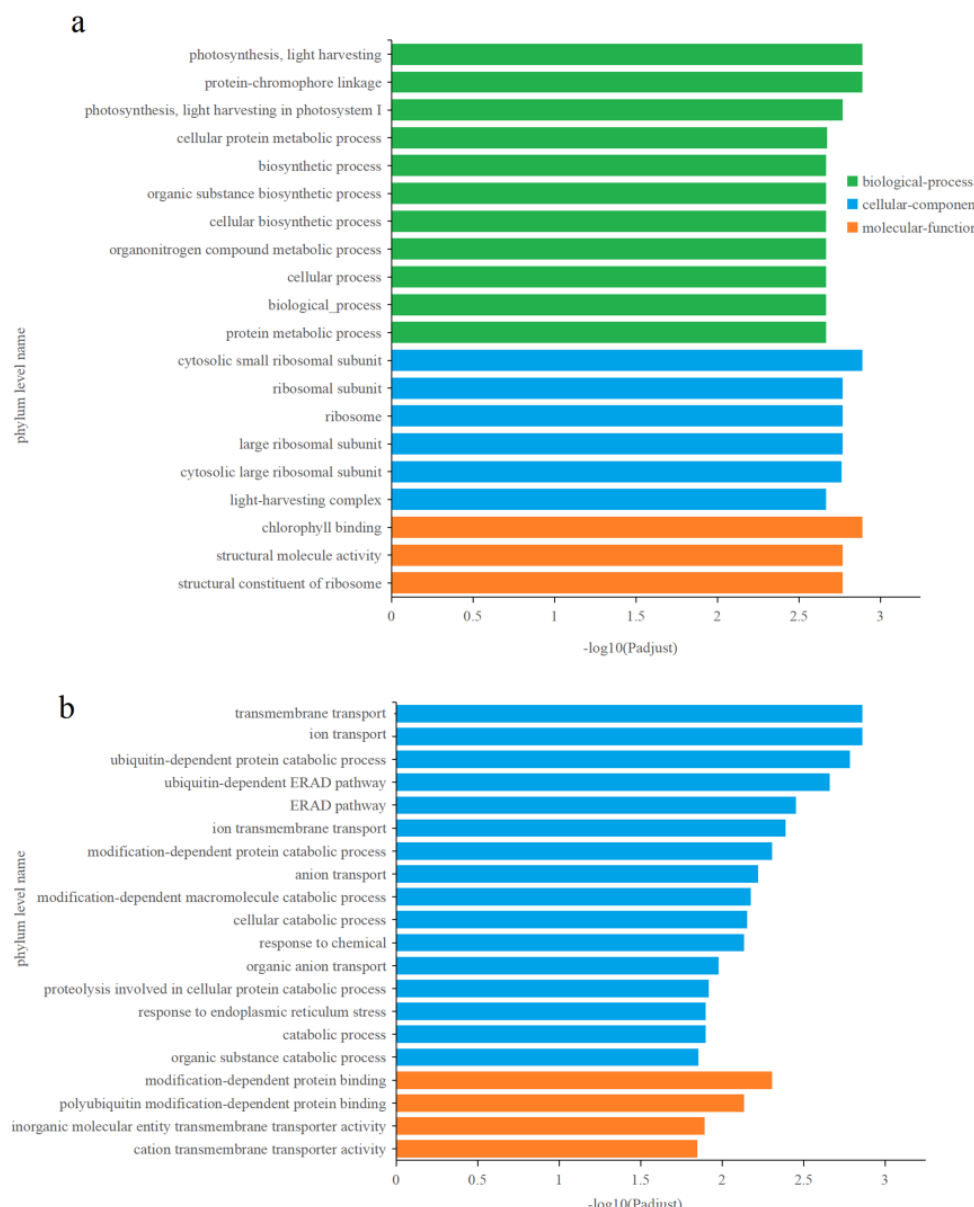
Figure 7. Gene Ontology (GO) enrichment analysis of differentially expressed genes (DEGs) in P. tricornutum under Zn 2+ treatment. ( a ) Upregulated genes in PTZn/PTC. ( b ) Downregulated genes in PTZn/PTC.